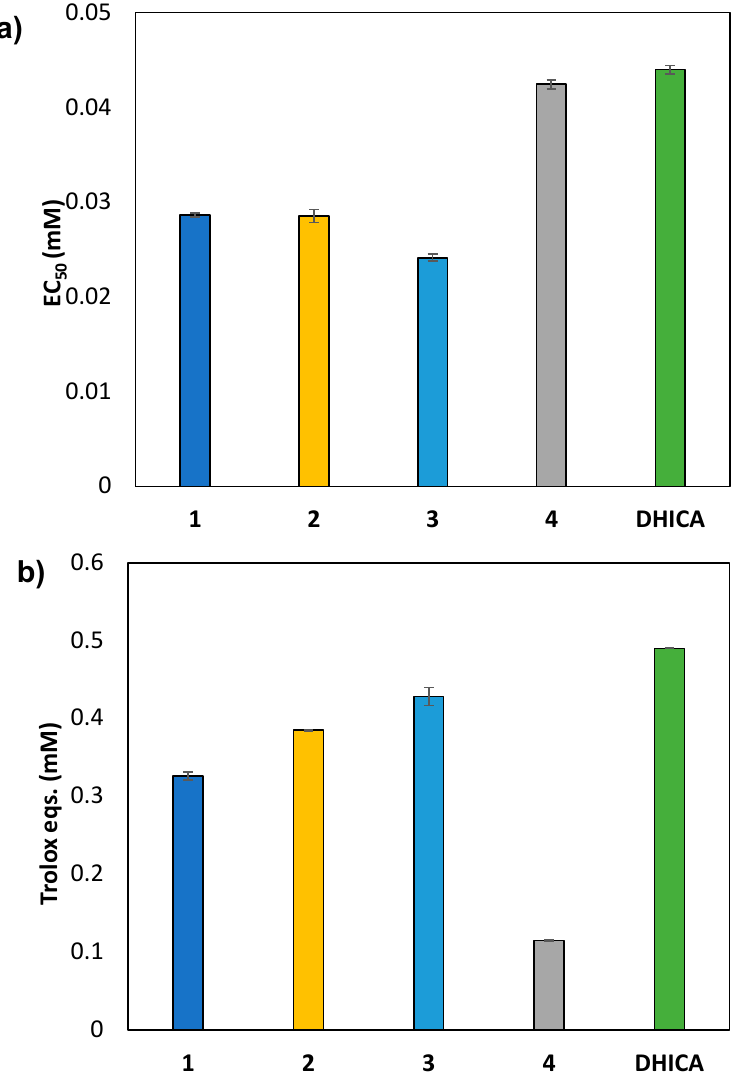
Figure 2. Antioxidant properties of DHICA carboxamides. ( a ) DPPH assay; ( b ) FRAP assay. Reported are the mean ± SD values of at least three experiments.